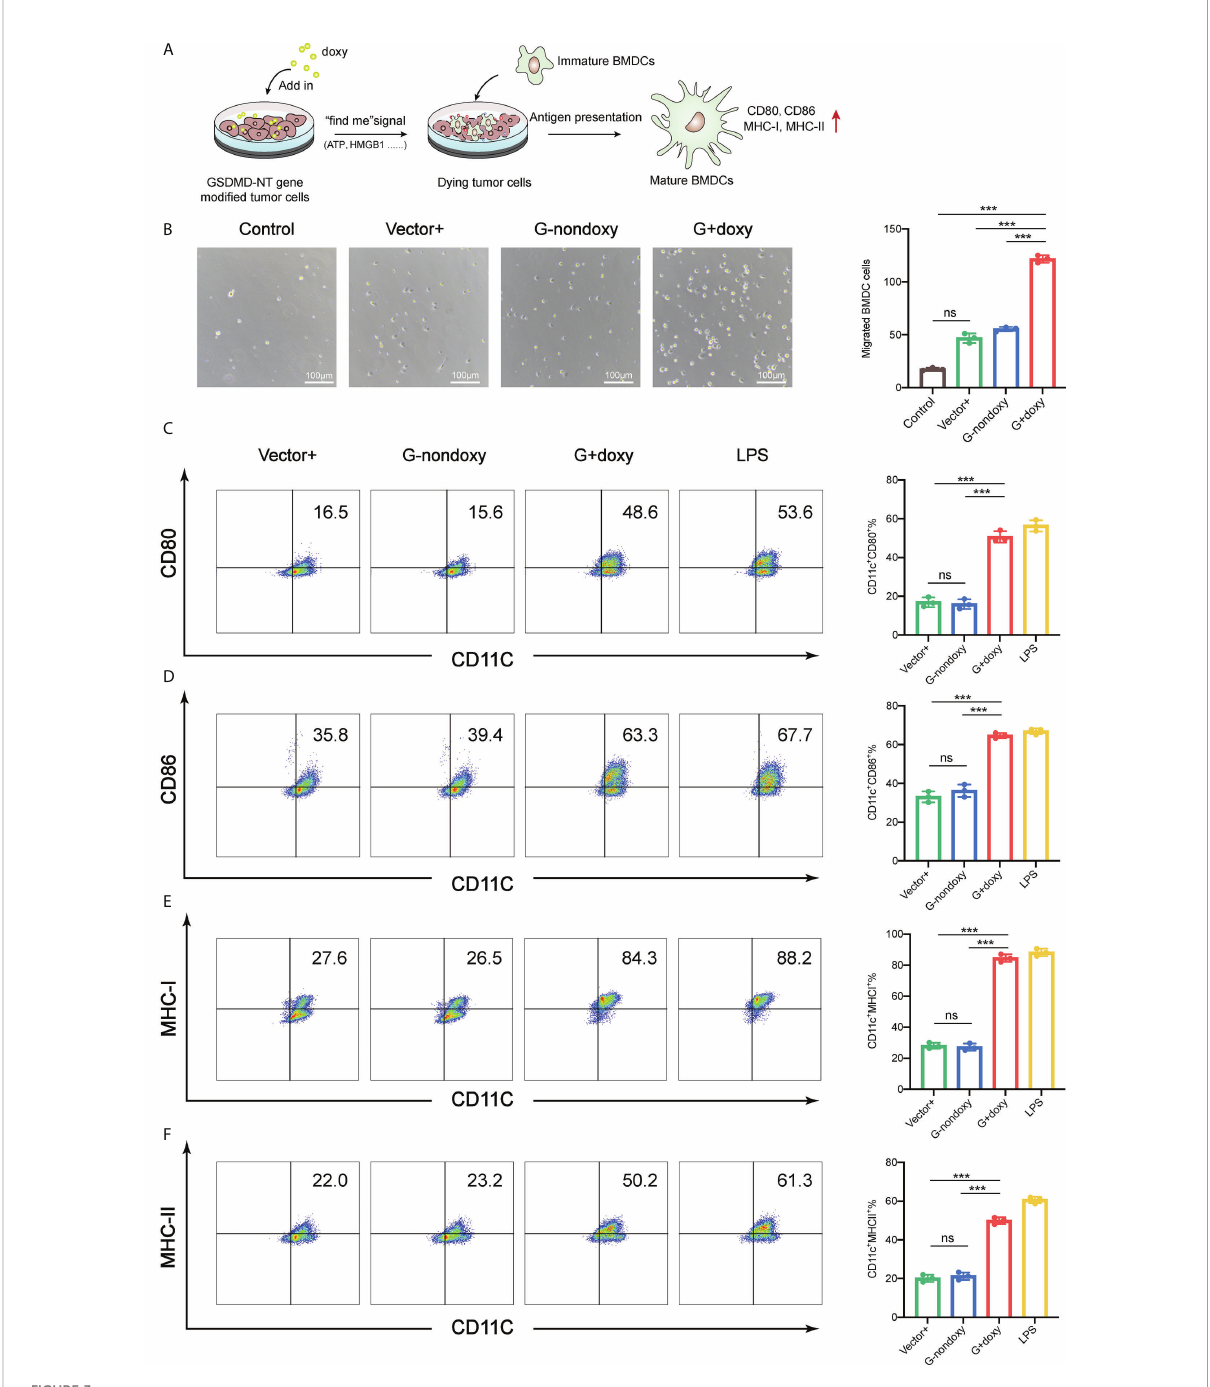
FIGURE 3 Immunogenic pyroptotic tumor cells promote the migration and maturation of BMDCs. (A) Pattern of immunogenic pyroptotic tumor cells promoting BMDC migration and maturation. (B) Transwell migration assays showed that the supernatant derived from the modi fi ed TC-1 cells incubated with doxy for 24 h induced the migration of BMDCs. Representative images and statistical analysis are presented. The “ control ” served as background contrast. Scale bar, 100 m m. (C – F) Representative fl ow cytometry pseudocolor dotplots for mature marker CD80-, CD86-, MHC-I-, and MHC-II-expressing cells in CD11c + BMDCs and the corresponding statistical analysis. The BMDCs were incubated with pyroptotic TC-1 cells for 18 h. LPS served as a positive control. (B – F) Graph shows means ± SD, One-way ANOVA, *** p value < 0.001, ns represents no signi fi